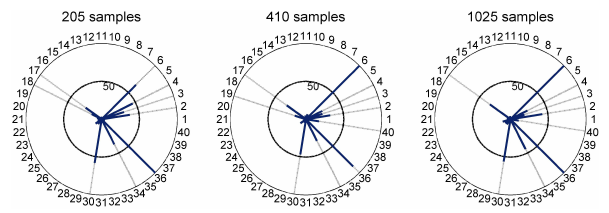
Fig. 5. The sensitivity score of sensible heat given by Morris method. The length of needles represents the sensitivity